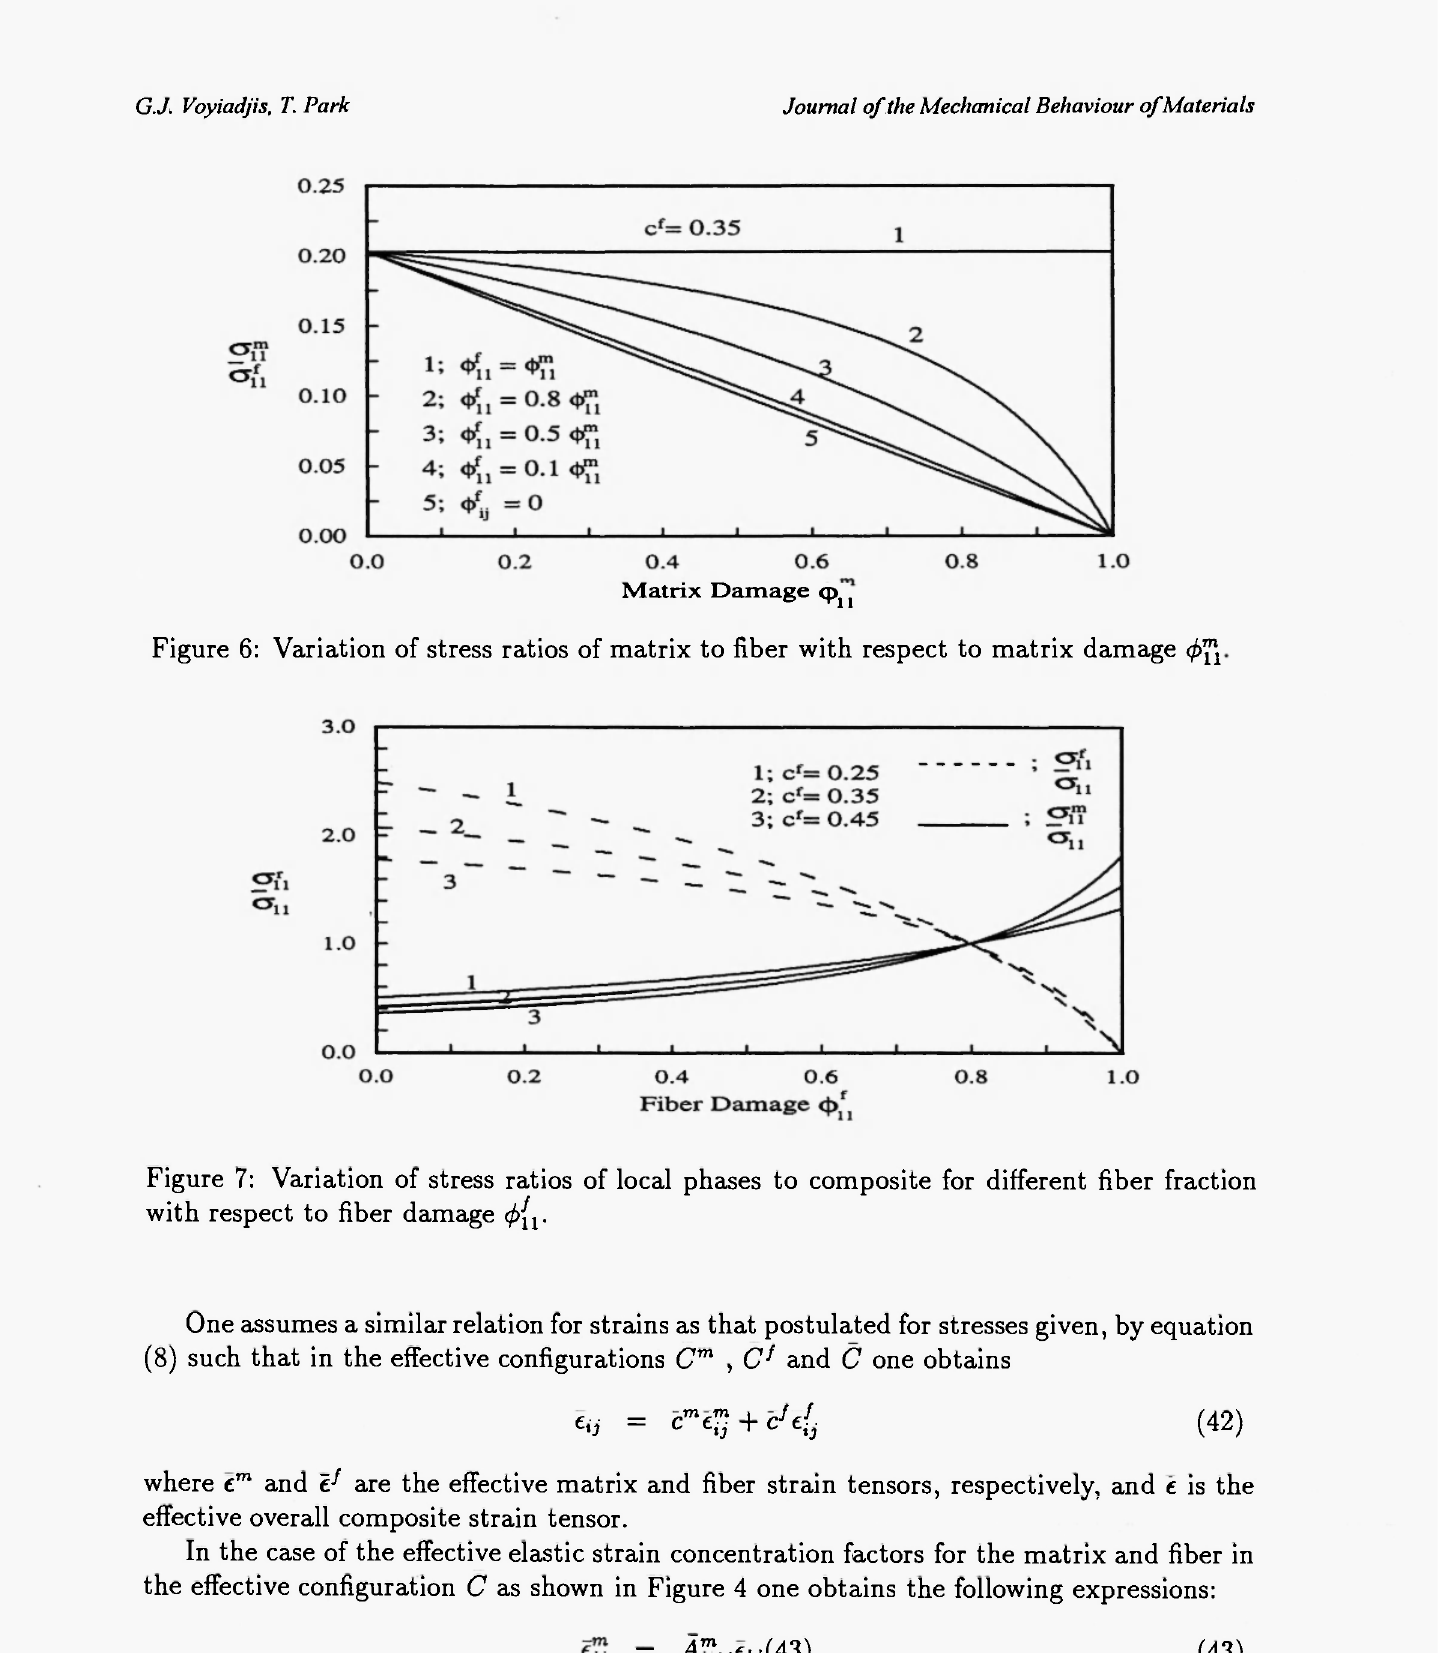
Figure 7: Variation of stress ratios of local phases to composite for different fiber fraction with respect to fiber damage φ[ χ